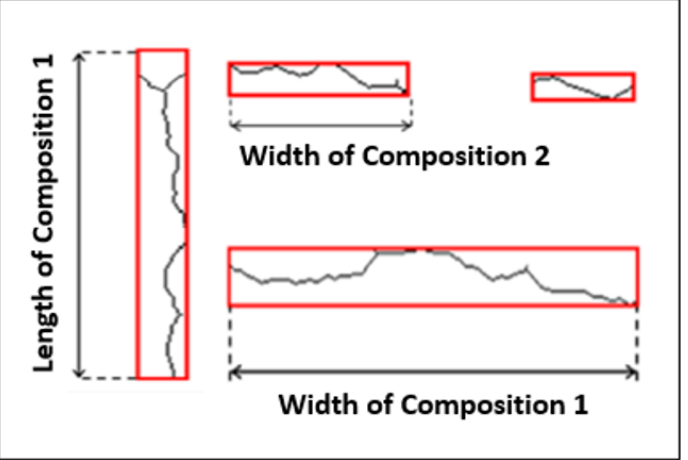
Figure 6. Length and width of the crack. The approximate size of the crack is depicted in the red box using a rectangle.